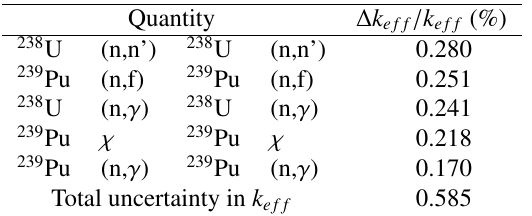
Table 10. k ef f k ef f uncertainty quantification for ALFRED with posterior JENDL-4.0u2 obtained with the DA of